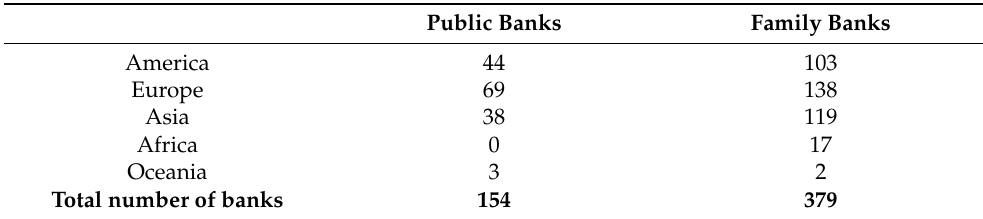
Table 1. Number of UC blood banks worldwide (according to the Parent’s Guide to Cord Blood